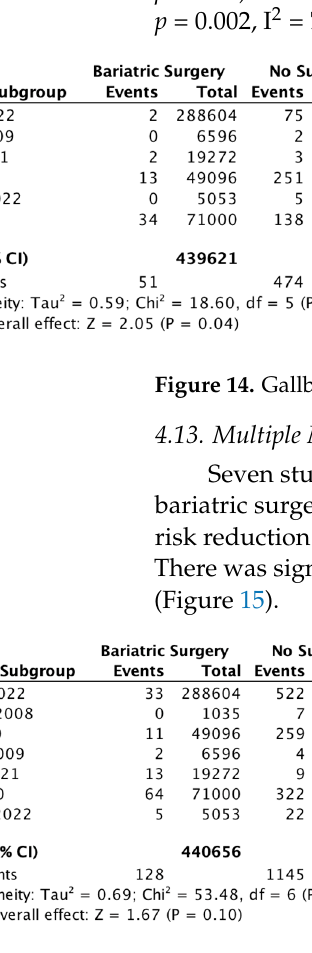
Figure 15. Multiple myeloma incidence [38–40,42,43,49,50].